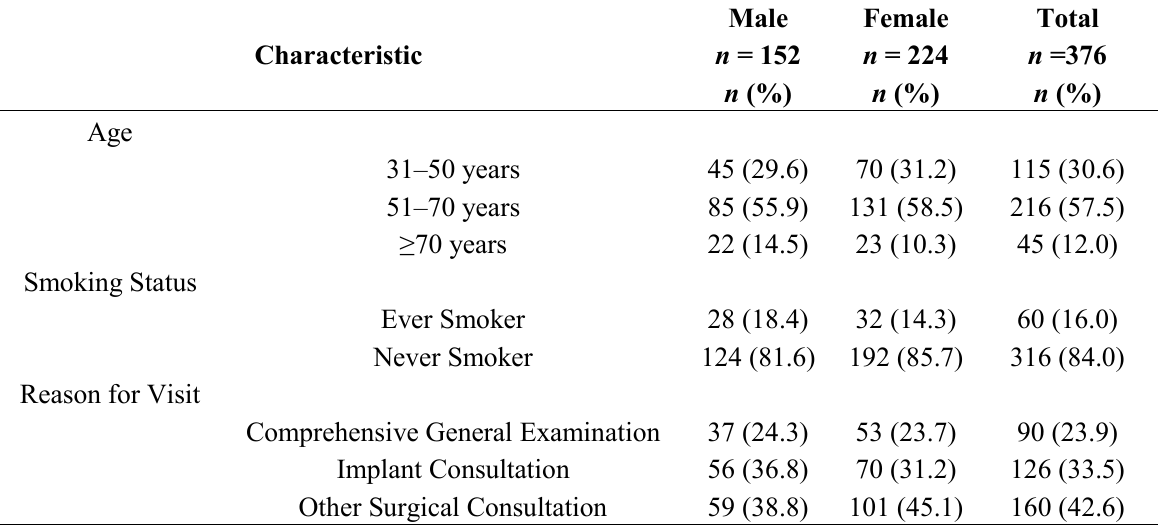
Table 1. Characteristics of Study